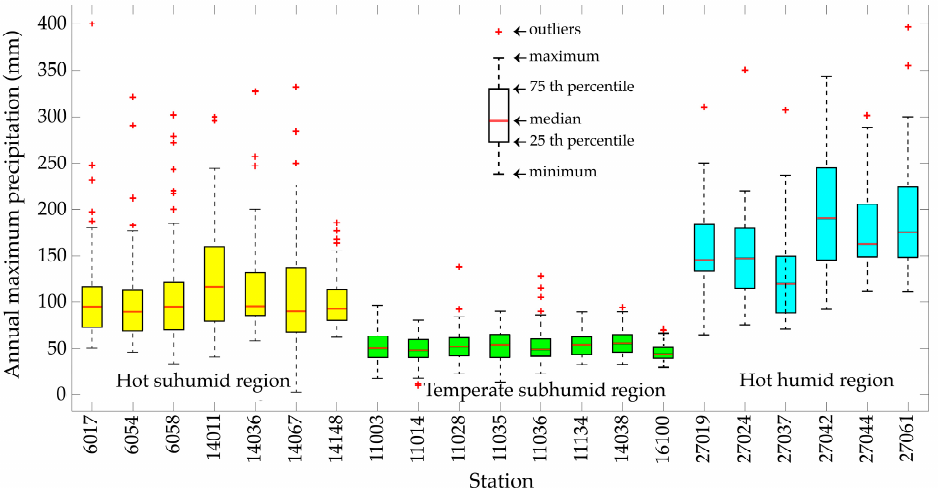
Figure 3. Maximum yearly precipitation recorded at the stations included in the analysis.